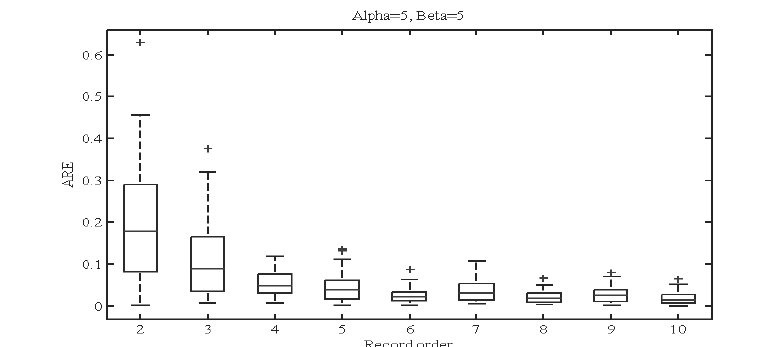
Figure 5 – Skewness coefficient of